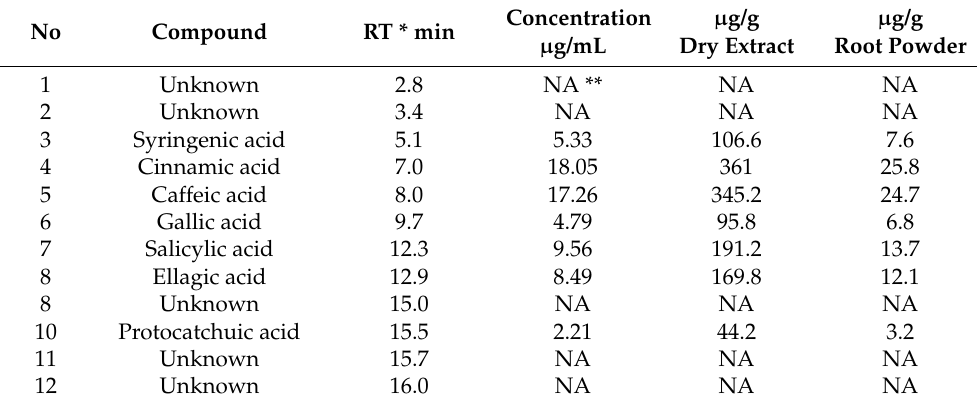
Table 2. Concentrations of phenol components of Alchemilla vulgaris root extract screened by HPLC. No Compound RT *